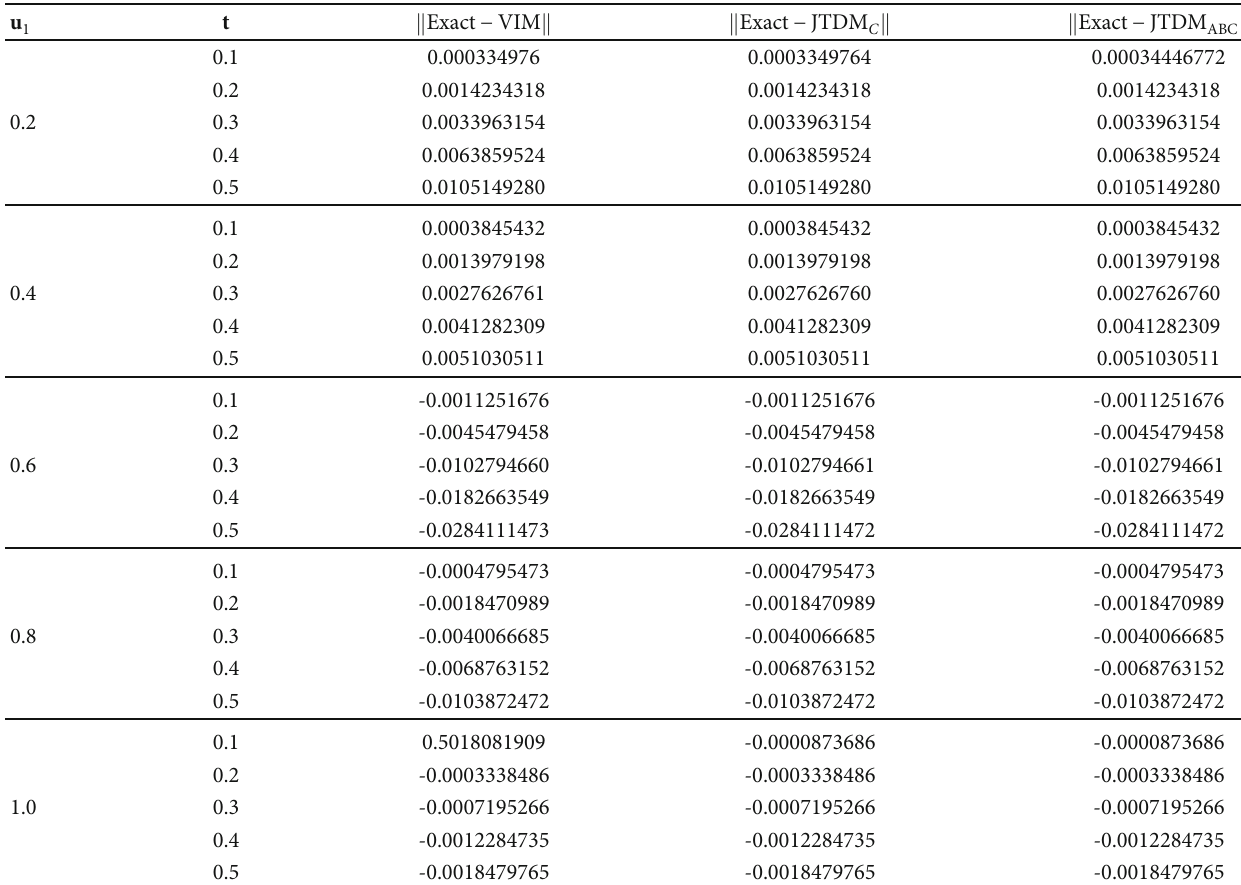
Table 3: The comparison study among VIM [16], JTDM error E abs = k E exact − E approx k at δ 1 = 1 considering multiple values of u 1 and t